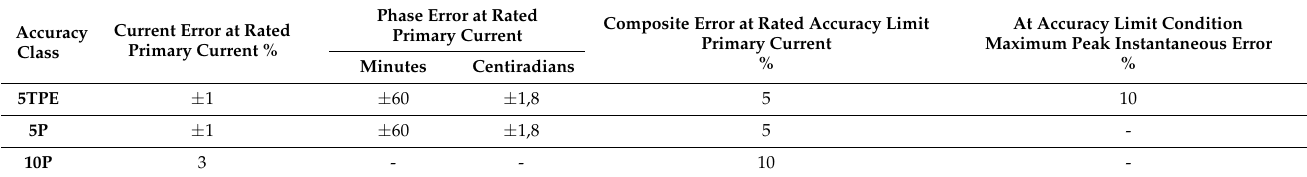
Table 3. IEC protection class